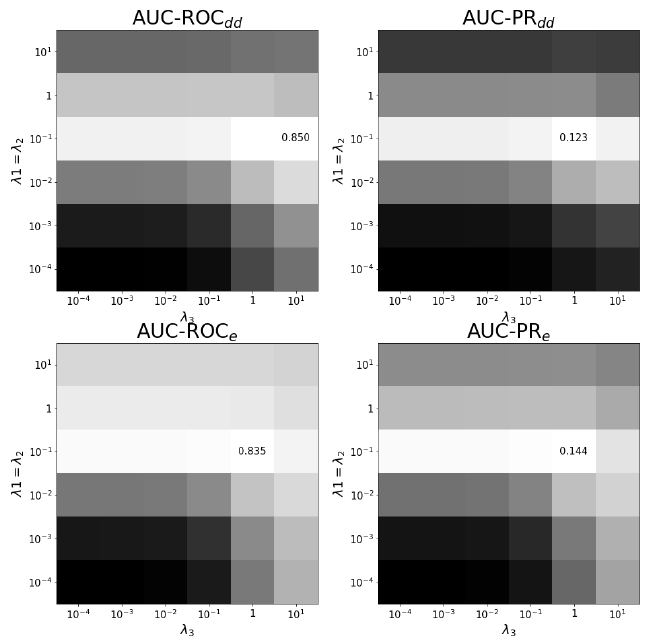
Figure A5. Tuning regularization parameters for task (cid:98) d (cid:98) de . The average of performance on ten training folds using shortcuts for leave-out validation is shown for different combinations of regu- larization parameters. The optimal combination and values are shown. White corresponds to the highest performance and black to the lowest performance. Each panel has a different color scale as performance varies over different